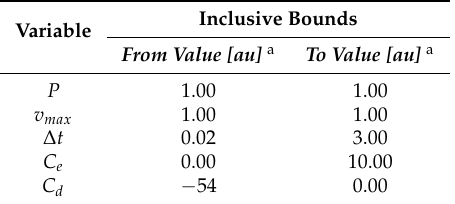
Table 1. Simulation Variable Bounds for Data Set